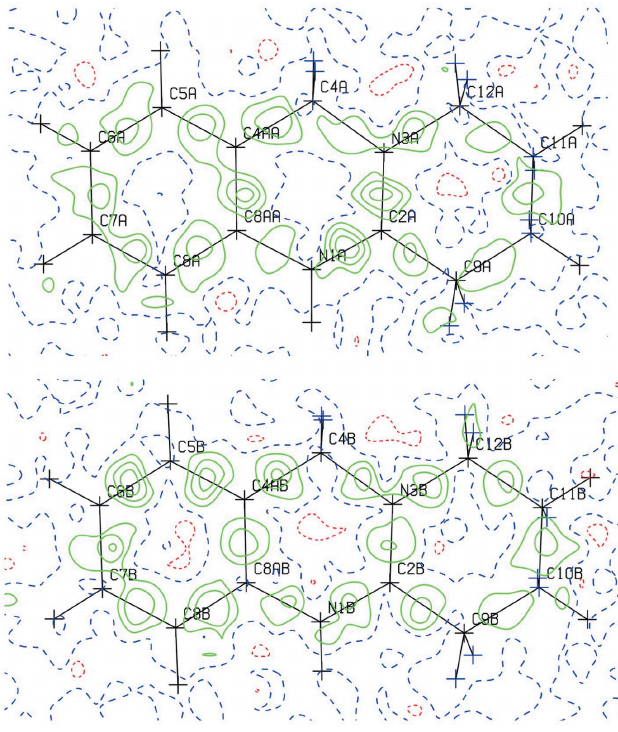
Figure 3 Residual electron density in the planes through C2 A , C4 A and C8 AA (top) and C2 B , C4 B and C4 AB (bottom); contour lines are drawn at 0.2 e A˚ (cid:3) 3 . Covalent bonds in the heterocyclic cations clearly show up as local density